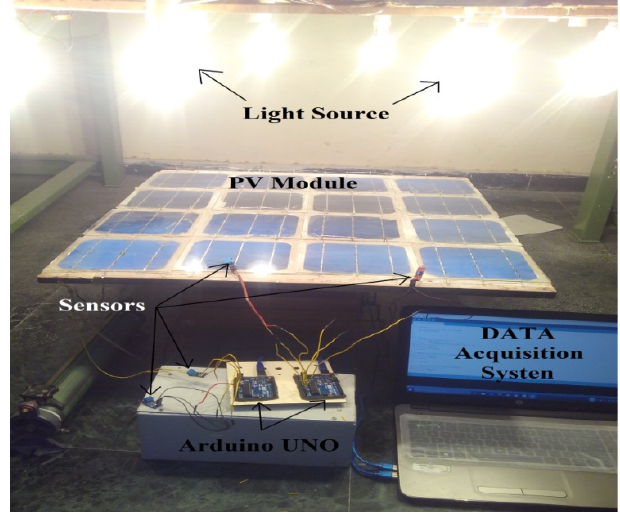
Figure 2. Experimental setup for